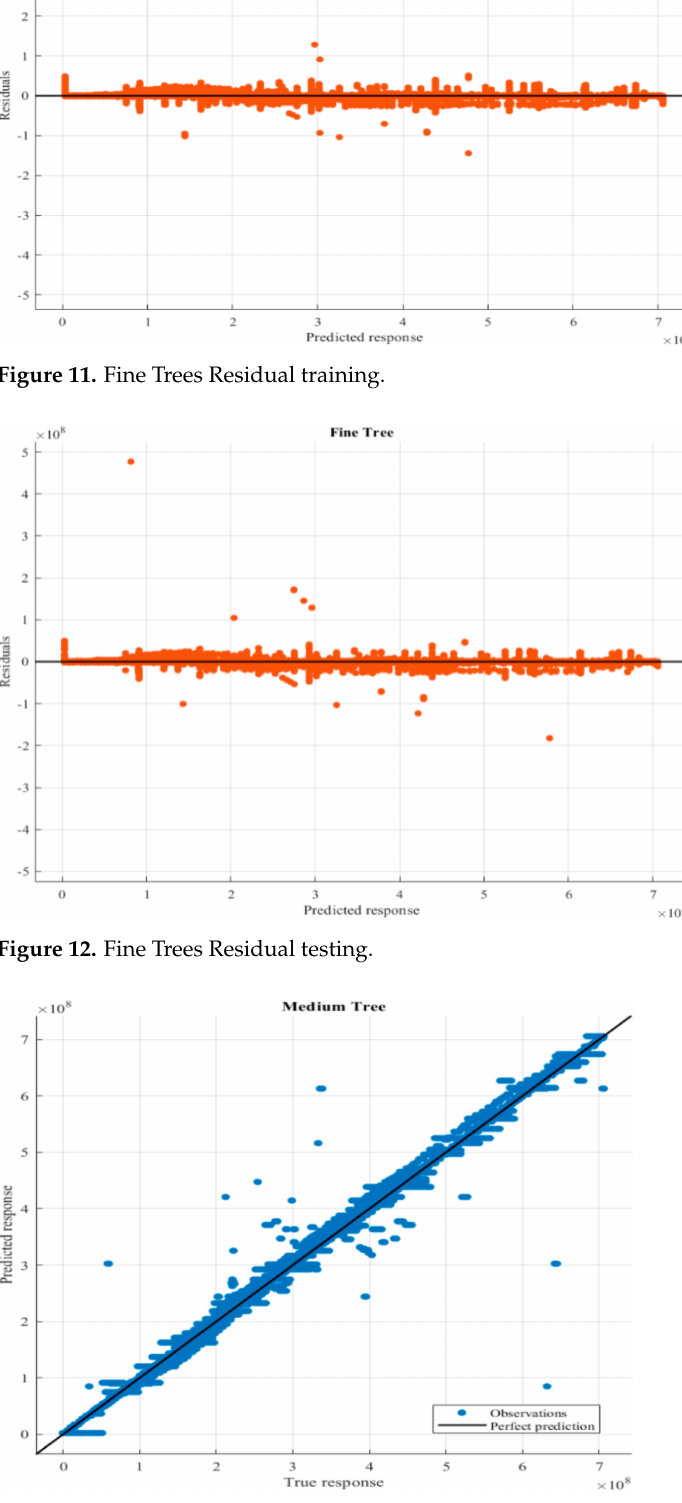
Figure 13. Medium Trees Prediction vs. Actual